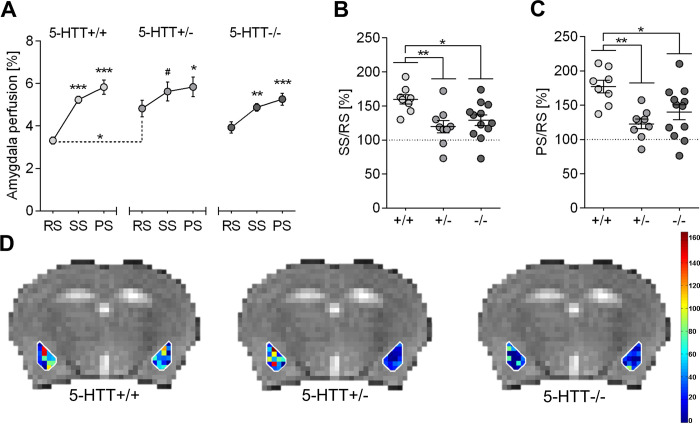
CBF perfusion levels in the amygdala of male mice are influenced by the 5-Htt genotype.A: Cerebral perfusion levels during resting state (RS), stimulation state (SS) and post-stimulation state (PS) in the amygdala of male mice of all three 5-Htt genotypes. Data represent mean perfusion level ± SEM; Statistical analysis was performed using two-way mixed ANOVA with genotype (5-Htt+/+, 5-Htt+/-, 5-Htt-/-) as between-subjects factor and phase (RS, SS, PRS) as within-subjects factor. Bonferroni post hoc tests were applied for pairwaise comparisons. As with RS and SS perfusion data the assumption of homogeneity of variance is violated Welch`s ANOVA was applied for testing genotype effects in these two phases followed by Games-Howell post hoc tests. Significant differences between the SS or PS state compared to the RS state within the separate genotype groups are indicated. The bracket with dashed lines point to genotype-dependent differences of RS perfusion levels. *** p < 0.001, ** p ≤ 0.01, * p ≤ 0.05, # p ≤ 0.1. B: Data points represent individual percental increase in amygdala CBF levels in male 5-HTT+/+, +/- and -/- mice from RS to SS and mean percental increase ± SEM. C: Data points represent individual percental increase in amygdala CBF levels in male 5-HTT+/+, +/- and -/- mice from RS to PS and mean percental increase ± SEM; Statistical analysis using one-way ANOVA with genotype as between-subject factor and Bonferroni post hoc test. ** p ≤ 0.01, * p ≤ 0.05. D: Visual representation of perfusion level changes from RS to SS in male mice of different 5-Htt genotypes during aversive odor presentation. Individual voxel-based calculation of amygdala perfusion level changes depicted in colors corresponding to different values.